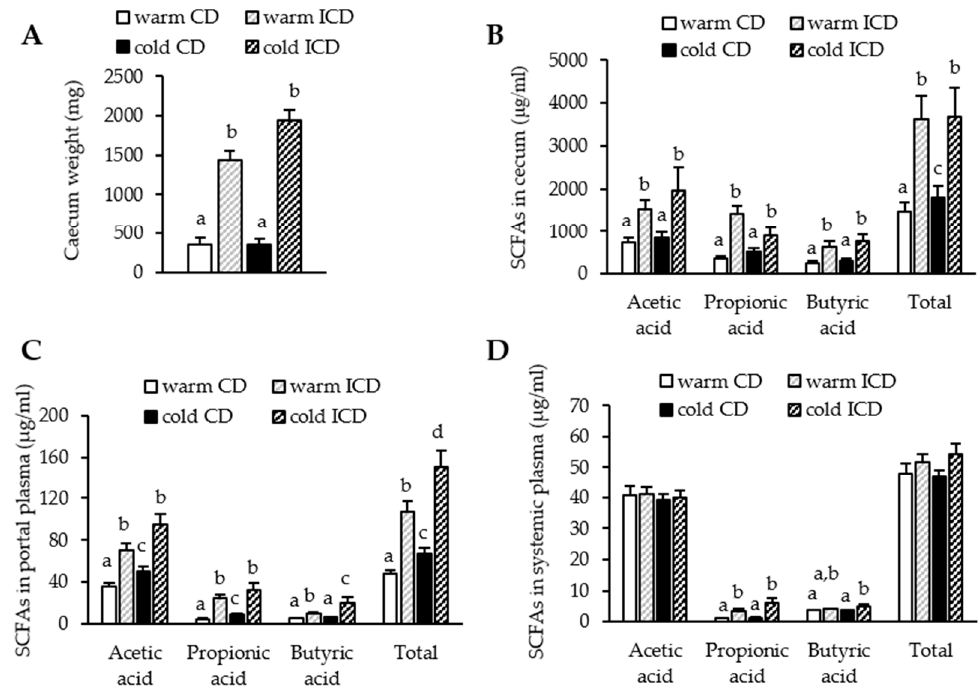
Figure 2. Inulin supplementation increases SCFA levels. ( A ) Cecum weight; SCFAs in ( B ) cecal content, ( C ) portal plasma and ( D ) systemic plasma. Data are shown as mean values ± SEM, and different letters indicate significant differences between groups ( p < 0.05) determined by two-way ANOVA. CD warm: n = 6; ICD warm: n = 6; CD cold: n = 6; ICD cold: n = 5 (ICD cold cecal content n = 4). SCFAs: short chain fatty acids.